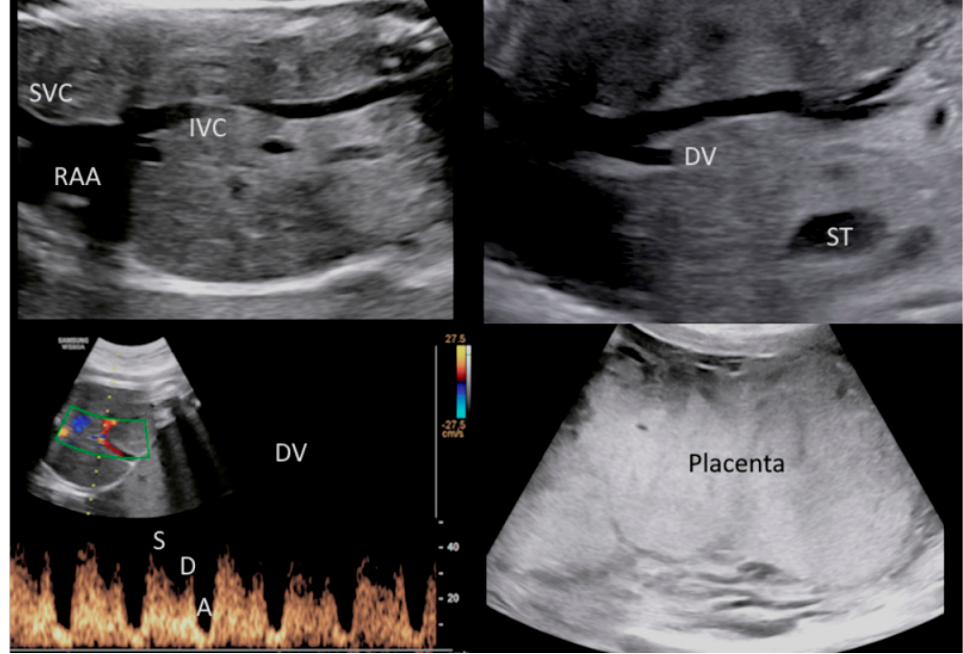
Figure 1. Transabdominal neuroscan ( A – E ) performed in the delivery room detected hyperecho- genicity ( D , open arrows) involving both choroid plexuses of the lateral ventricles (LV) as well as the falx cerebri . Brain contour was smooth without recognizable gyri and sulci ( A , B , E ). (Legend: CC: corpus callosum; LV: lateral ventricle).